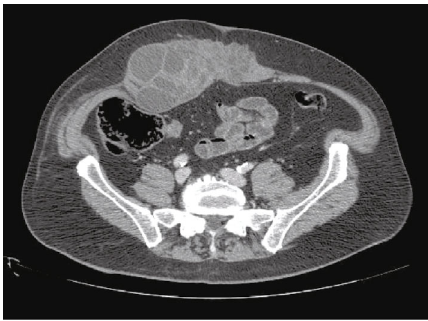
Figure 2: Heterogeneous mass in the abdominal wall that a ff ects the rectus abdominis muscle, predominantly cystic with septa